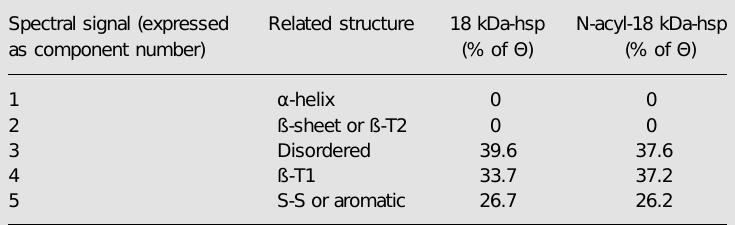
Θ in 10 -3 degree cm 2 decimol -1